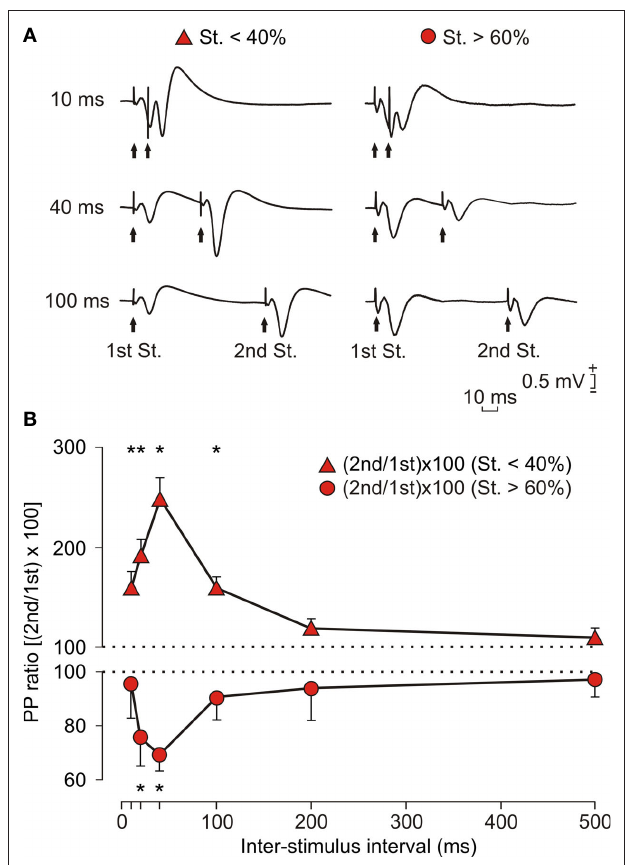
FIGURE 3 | Effects of paired-pulse stimulation of the CA3-CA1 synapse at two different intensities. (A) Representative records (average of three records) of fEPSPs evoked by paired-pulse stimulation at three different (10, 40, 100 ms) time intervals, and using intensities (mA) < 40% (red triangle and left set of records) and > 60% (red circle and right set of records) of the asymptotic value. (B) PPF (red triangles) and PPD (red circles) of fEPSPs recorded in the CA1 area following stimulation of the ipsilateral Schaffer collaterals ( n = 10 animals). PPF (red triangles) was evoked by stimulating Schaffer collaterals at intensities < 40% of the asymptotic values, whilst PPD (red circles) was evoked by intensities > 60% of asymptotic values. Field EPSPs paired traces were collected at inter-pulse intervals of 10, 20, 40, 100, 200, and 500 ms. The data shown are mean ± SEM slopes of the second fi eld EPSP expressed as a percentage of the fi rst [(2nd/1st) × 100] for the six inter- stimulus intervals used in this study. [F = 6.213]; * P < 0.01 for PPF and (10,90) P < 0.05 for